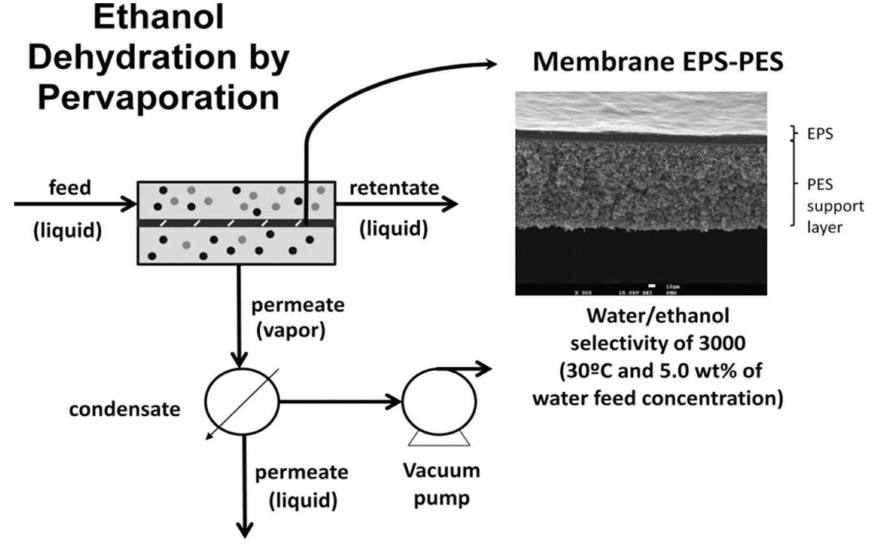
Figure 8. Scheme of ethanol dehydration by pervaporation (left) and the composite membrane of the crosslinked EPS supported in polyethersulfone (EPS-PES) (right). Reprinted with permission from Meireles et al. [224]. Copyright 2013,